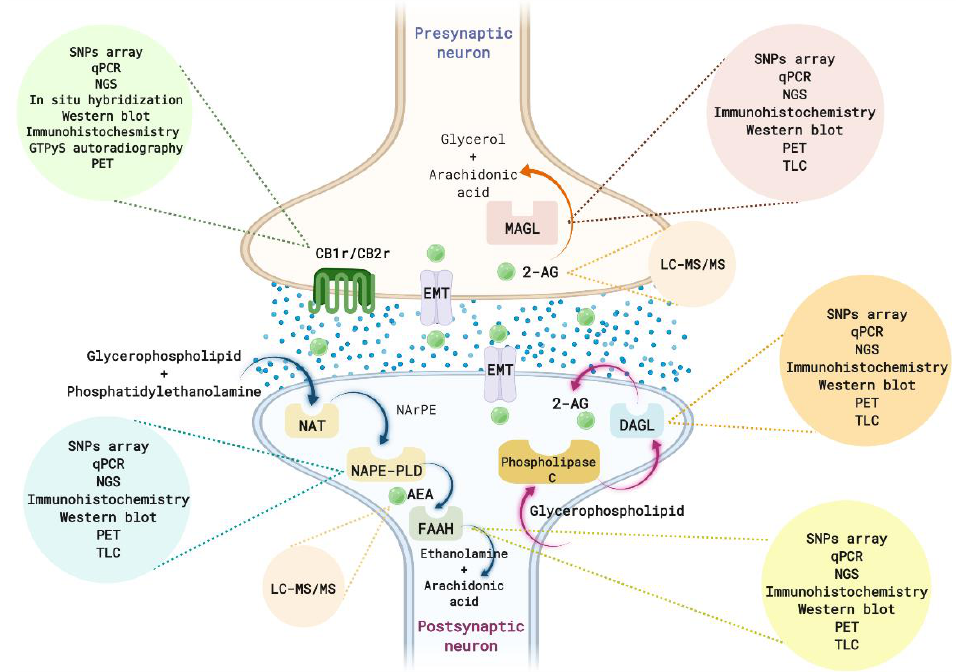
Figure 1. Schematic representation of the main methods used for identifying alterations in the